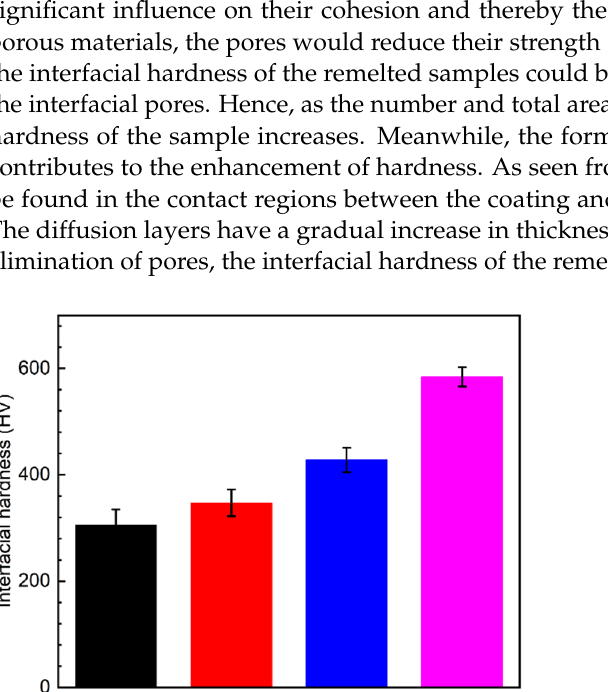
Figure 7. Bond strength of the as-sprayed NiCrBSi, S20, S25 and S30 samples. S20, S25, and S30 indicate the as-sprayed NiCrBSi coatings remelted at 20 kW, 25 kW, and 30 kW. 3.5. Relationship between the Total Areas of the Coating Samples and Their Mechanical Properties The relationship between the total area of interfacial pores and bond strength of NiCrBSi coatings and the relationship between the total area of interfacial pores and in- terfacial hardness are plotted in Figure 8. Similar to other materials, the presence of pores decreases the strength of the materials or coating adhesion/cohesion [50–53]. A linear re- lationship between hardness and logarithmic value of total pore area is found. The slope